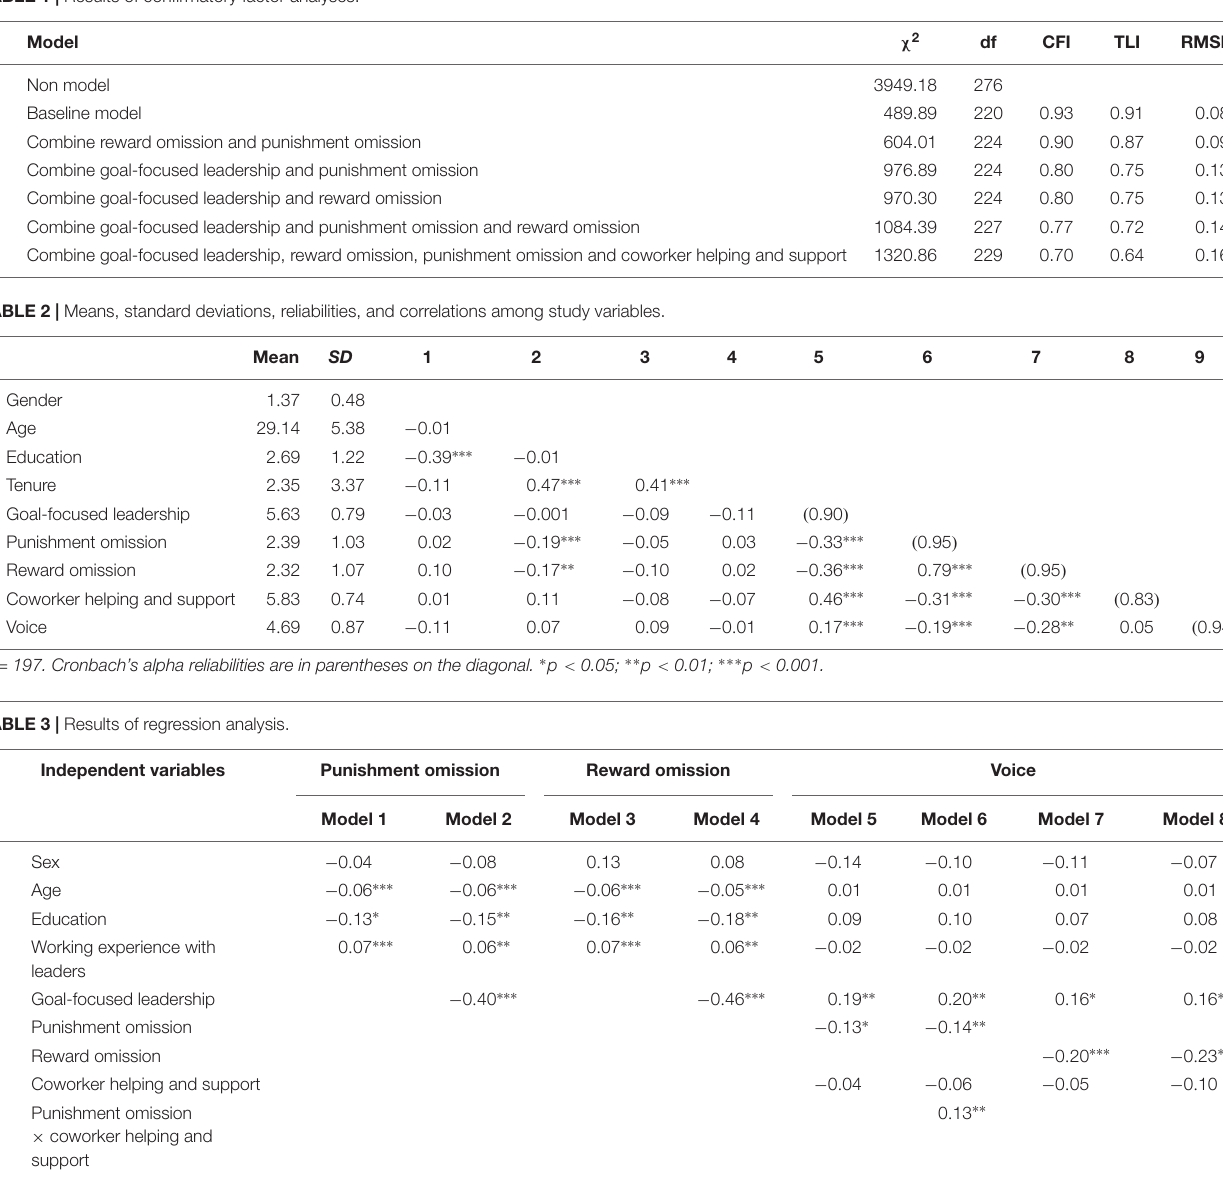
TABLE 1 | Results of confirmatory factor analyses.